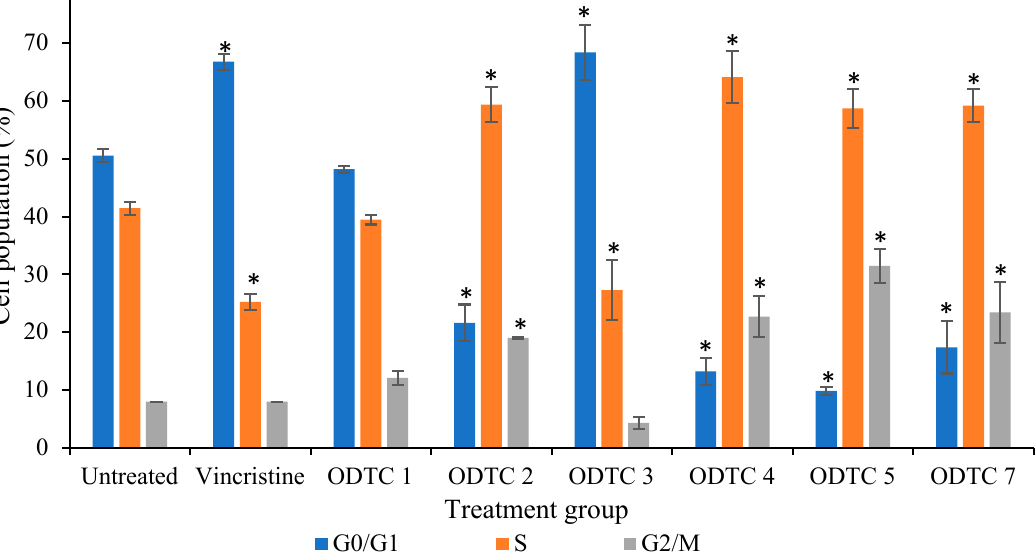
Figure 3. ( a ) Flow cytometry analysis of Jurkat E6.1 cells stained with Annexin V − FITC/PI after treatment with ODTC 1, ODTC 2, ODTC 3, ODTC 4, ODTC 5, ODTC 7 and vincristine at their respective IC 50 concentrations. ( b ) The percentage of viable, apoptotic (early and late), and necrotic populations are as depicted. The data show the mean percentage of cells (%) ± SEM obtained from three independent experiments. * Significant difference ( p < 0.05) from the negative control. From the results obtained, the triphenyltin(IV) series caused majority of cell death at apoptosis phase. ODTC 3 displayed a total of 87.5% apoptosis with 59.70 ± 1.96% of cell